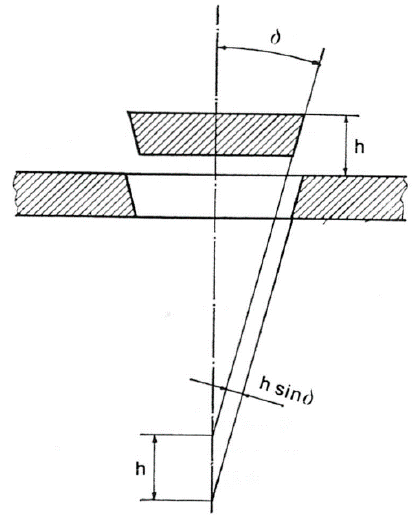
Figure 2. Dish-shaped valve scheme.